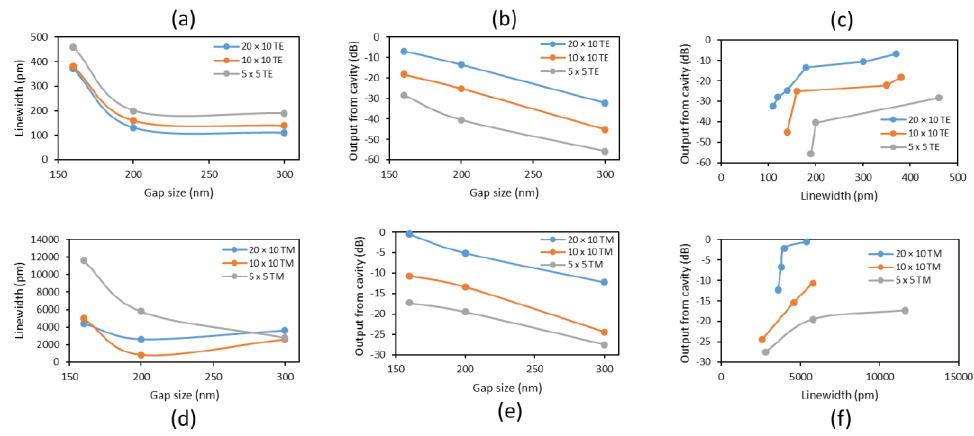
Figure 11. Characterization of coupling ideality for the fundamental TE ( a – c ) and TM ( d – f ) modes.